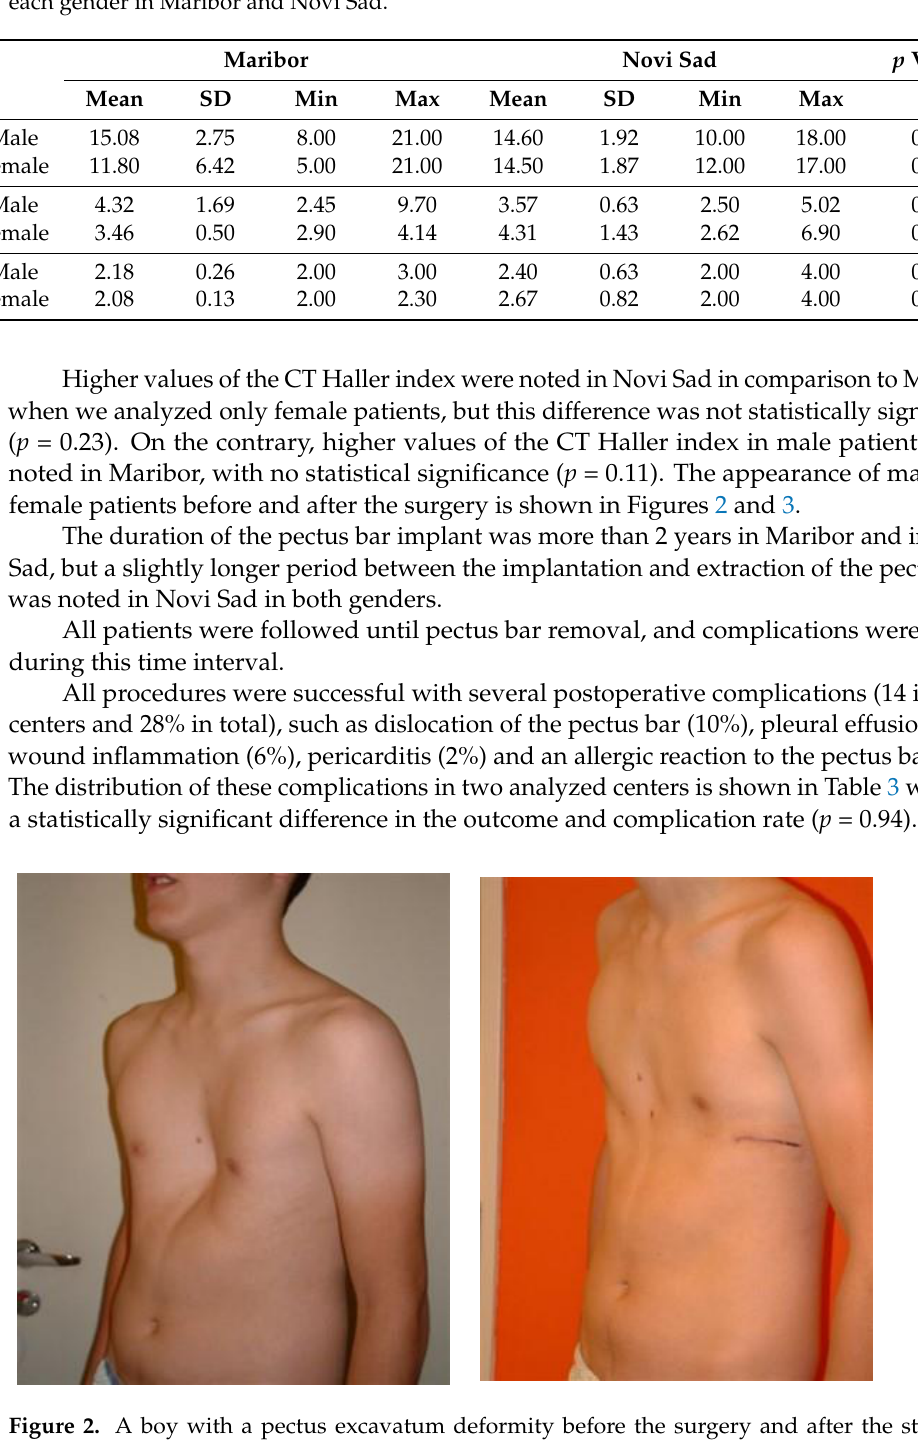
Table 2. Frequency values for age, the CT Haller index and duration of the pectus bar implant for each gender in Maribor and Novi Sad.